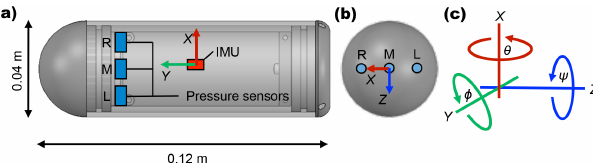
Figure 1. Dimensions of the multimodal drifter used in this work. The drifter includes three identical pressure transducers as well as a single inertial measurement unit (IMU). (a) Side view of the drifter. (b) Top view facing the cap showing the left (L), middle (M) and right (R) pressure ports. (c) Body-oriented drifter coordinate system including the roll ( φ ), pitch ( θ ) and yaw ( ψ )